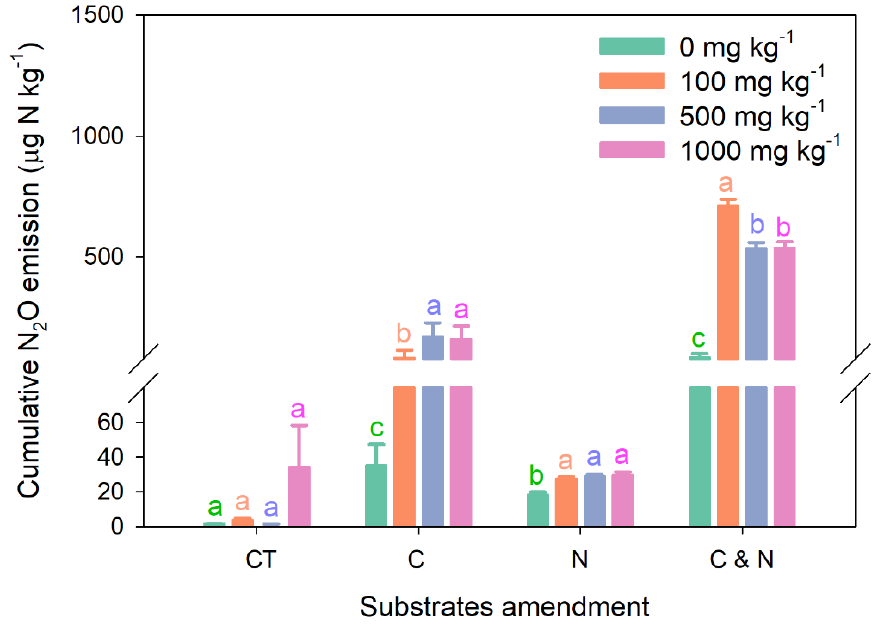
Figure 2. Cumulative N 2 O emissions in the treatments with no addition, C addition, N addition and